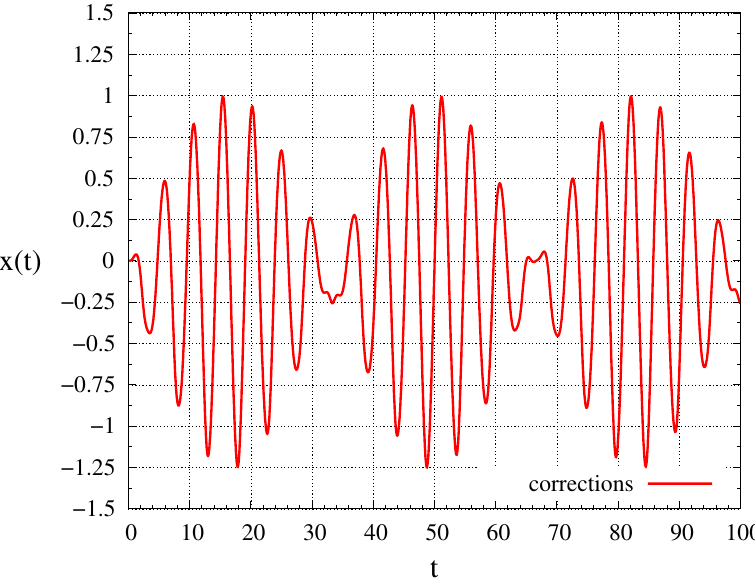
Figure 4. Amplitude changes, ∆ x ( t ) = x rel ( t ) − x clas ( t ) , characterizing the relativistic corrections for the classical harmonic oscillator in a strong uniform gravitational field, corresponding to the physical configuration of Figure 3, but for the larger time interval t ∈ [ 0,100 ] in units of seconds. These corrections are significant and modulate in both amplitude and